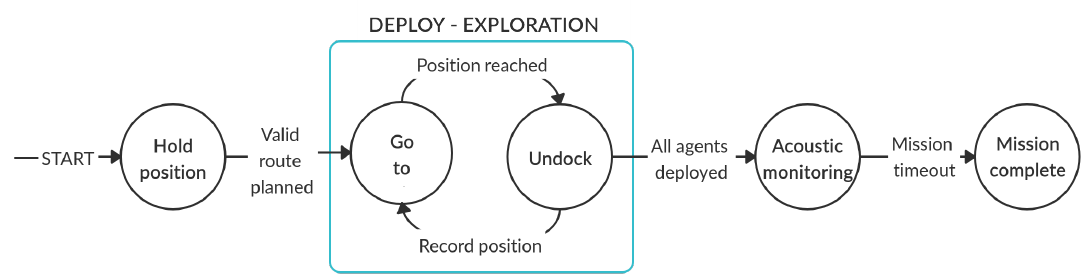
Figure 6. Anoxia scenario experiment for the aPad deploying exploration group agents (aPad P 1